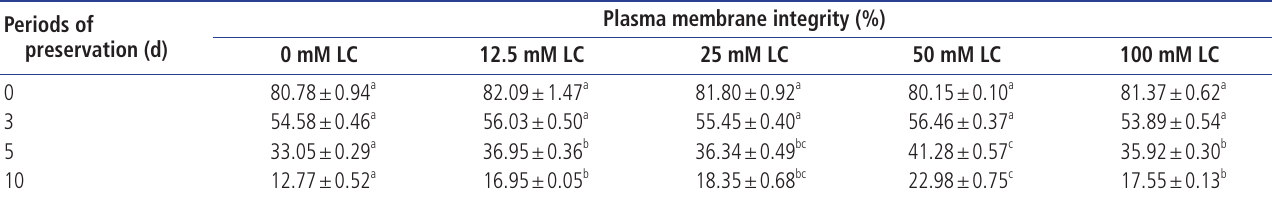
Table 2. Effects of L-carnitine on boar sperm plasma membrane integrity during preservation Periods of preservation (d)